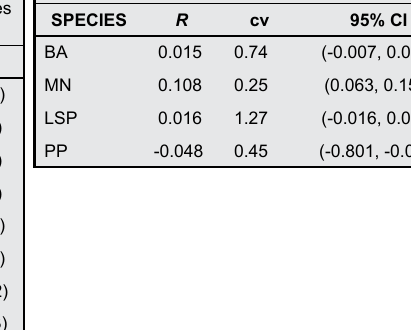
Table 9. Rate of increase/decrease in the survey area assessed using the GLM method. R – annual rate of increase. Species as in Table